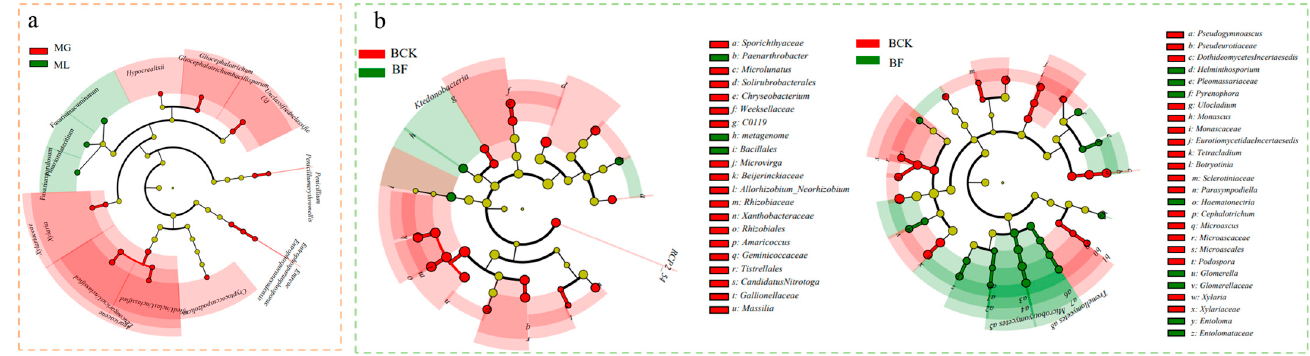
Figure 2. Differentiated taxa between groups and cladogram based on analyses results of LEfSe (with LDA score set as 2). ( a ) Comparison of grass (MG) and legume (ML) in rhizosphere fungal communities. ( b ) Comparison of bulk soil (BCK vs. BF) bacterial and fungal communities. From the inner circle to the outer circle of the cladogram, the yellow nodes indicate that there is no significant difference between the groups, while the other color nodes indicate that the group has a high abundance within the group and a significant difference between the groups.